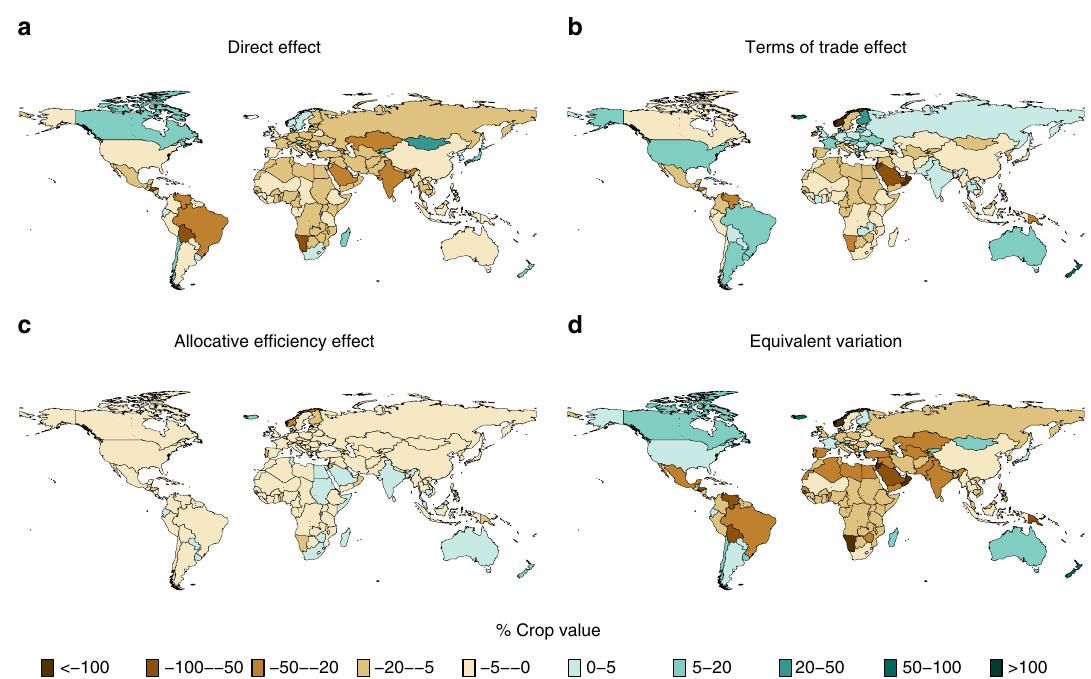
Fig. 2 Welfare changes from 3 °C of global average warming. Changes are relative to a 1995 – 2005 global average baseline and use yield changes based on the meta-analysis results shown in Fig. 1: a the direct technical effect of climate change on agricultural productivity; b terms of trade effects; c the allocative ef fi ciency effect; and d total welfare change reported as equivalent variation. Results are based on yield changes that include adaptation and the CO 2 fertilization effect for C 3 crops but not for maize. Welfare changes are normalized by the value of production of the affected crops (maize, rice, wheat, and